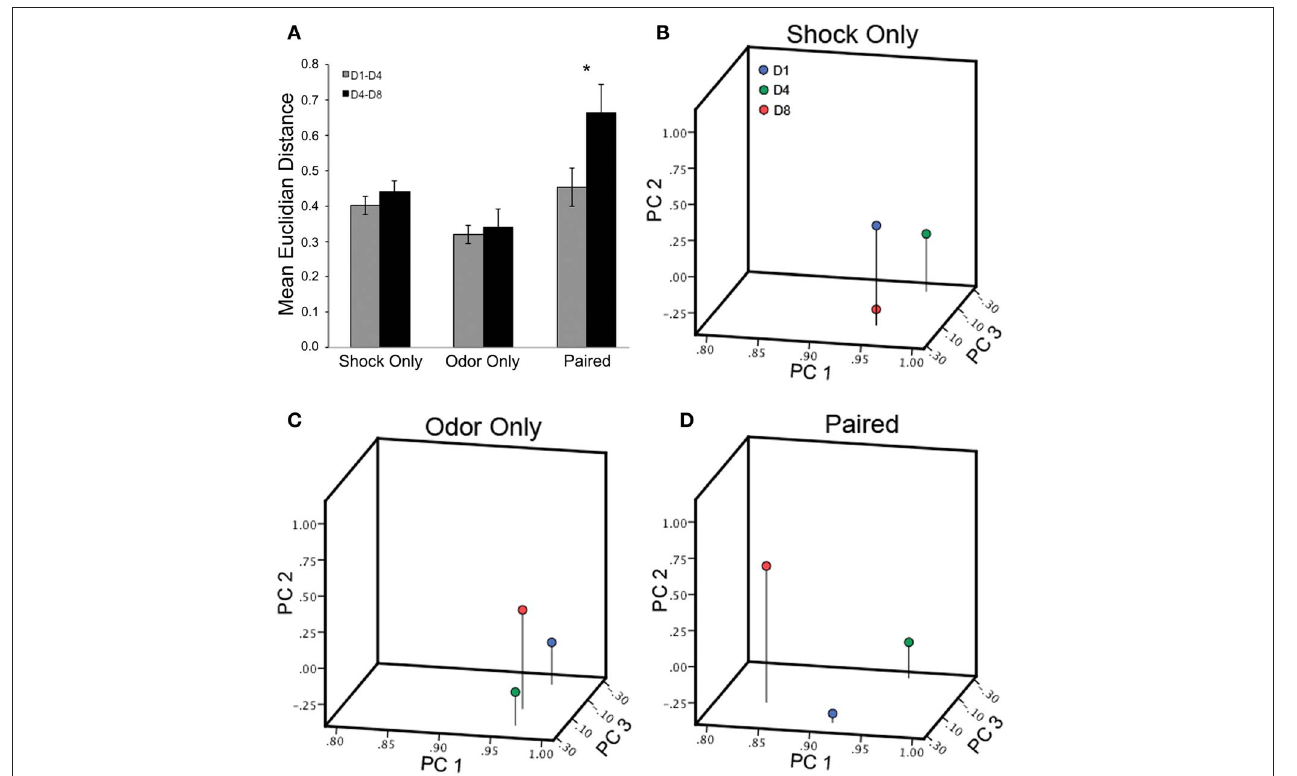
representations in odor space before and after conditioning in all three groups (Day 1: blue; Day 4: green; Day 8: red). In both the Shock only and Odor only groups, the post-training D8 odor representations are clustered close to the D1 and D4 responses. However, in the Paired group, the D8 response has shifted away from the D1 and D4 responses. ∗ Denotes a significant difference between the groups ( p < 0 .